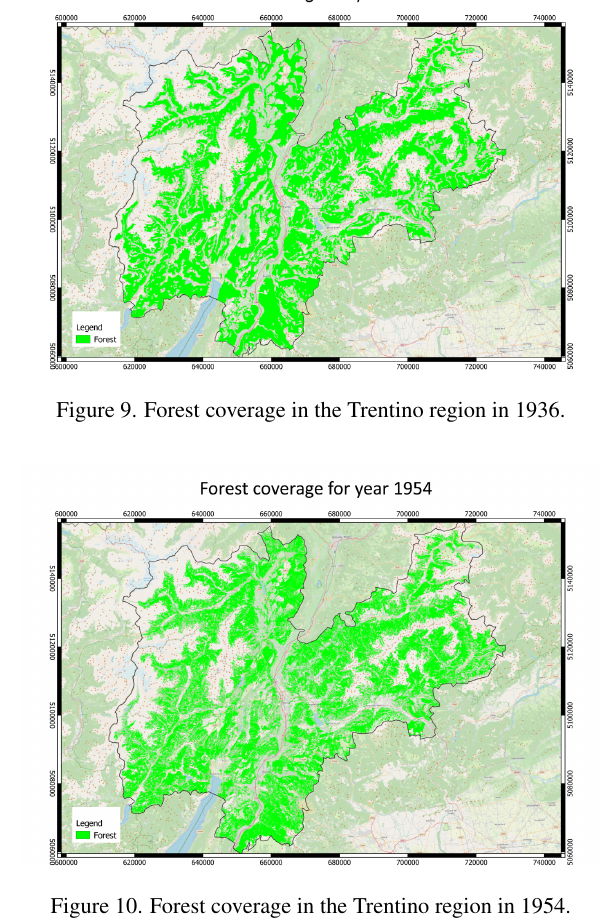
Figure 10. Forest coverage in the Trentino region in 1954.